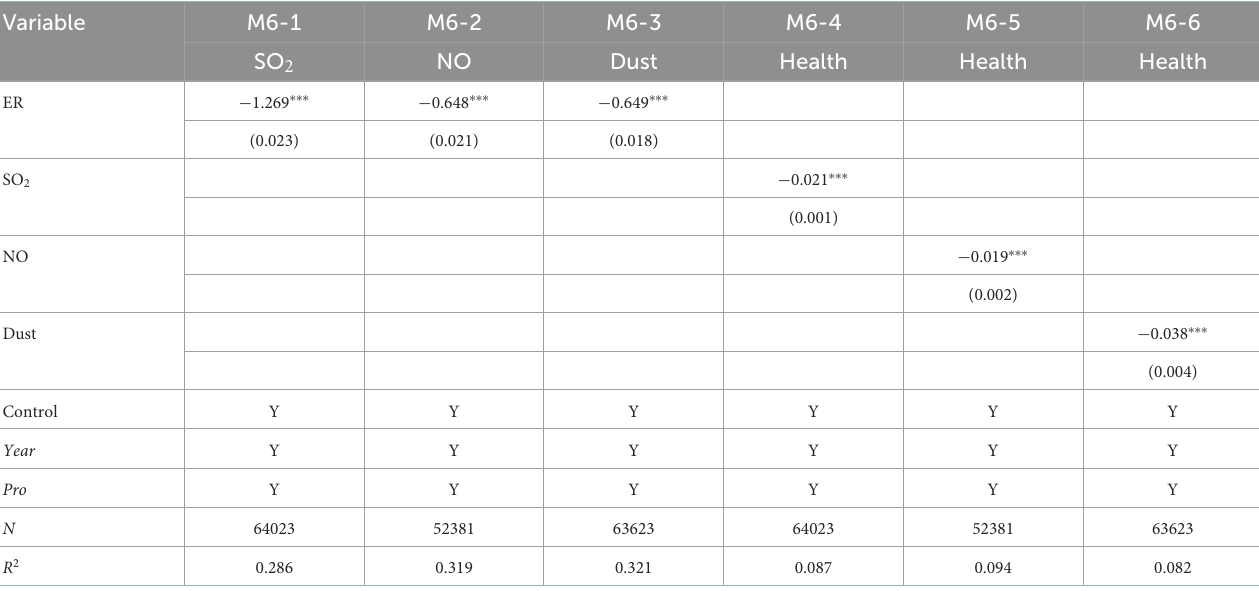
TABLE 6 Mechanism test (1).